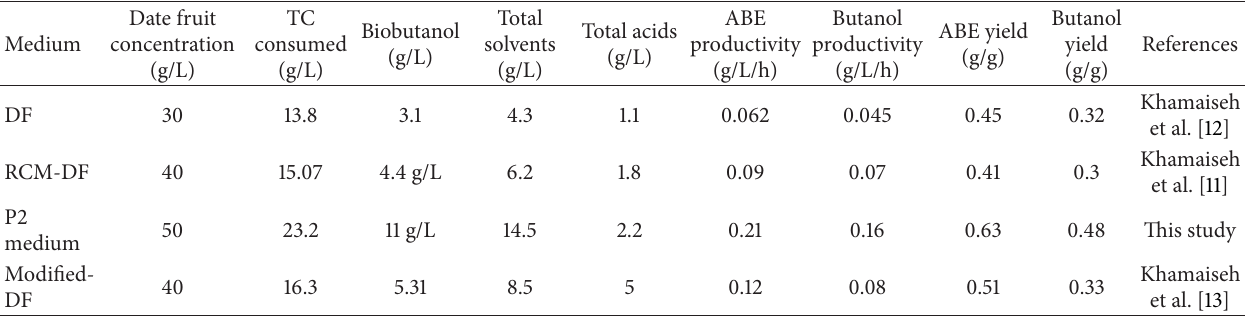
Table 3: A comparison of ABE and acids production from date fruit with different modified media in batch culture using C . acetobutylicum NCIMB 13357.